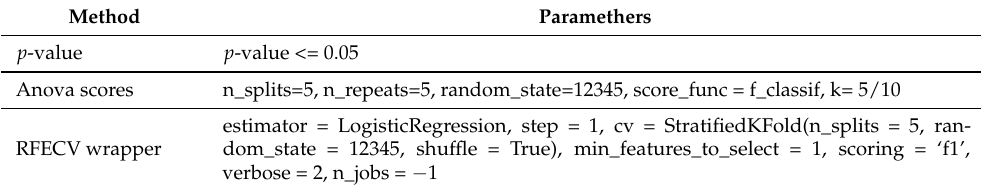
Table 2. Parameters used in the feature selection